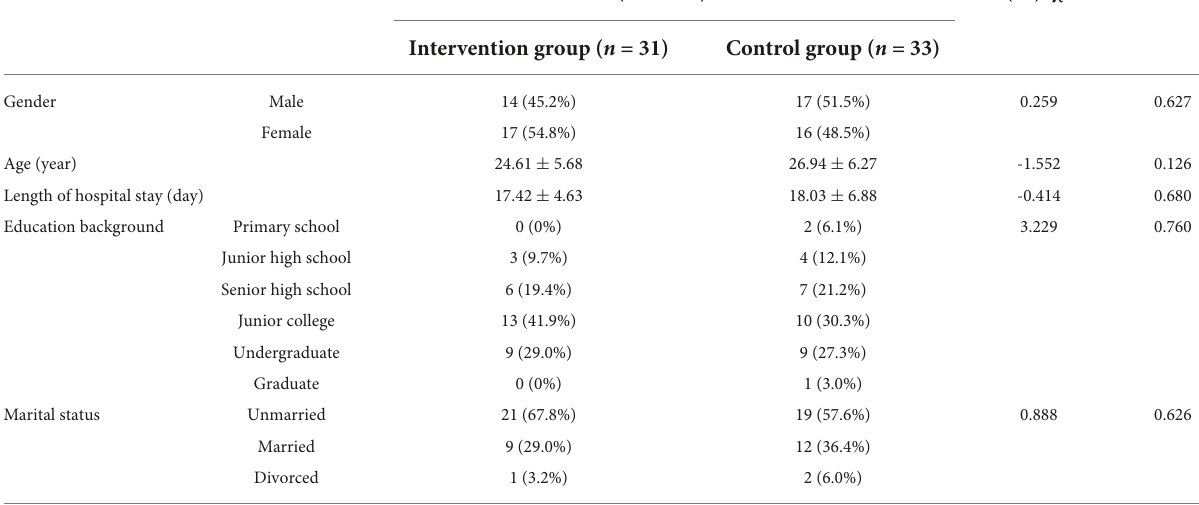
TABLE 1 Comparison of demographic characteristics between the intervention group and the control